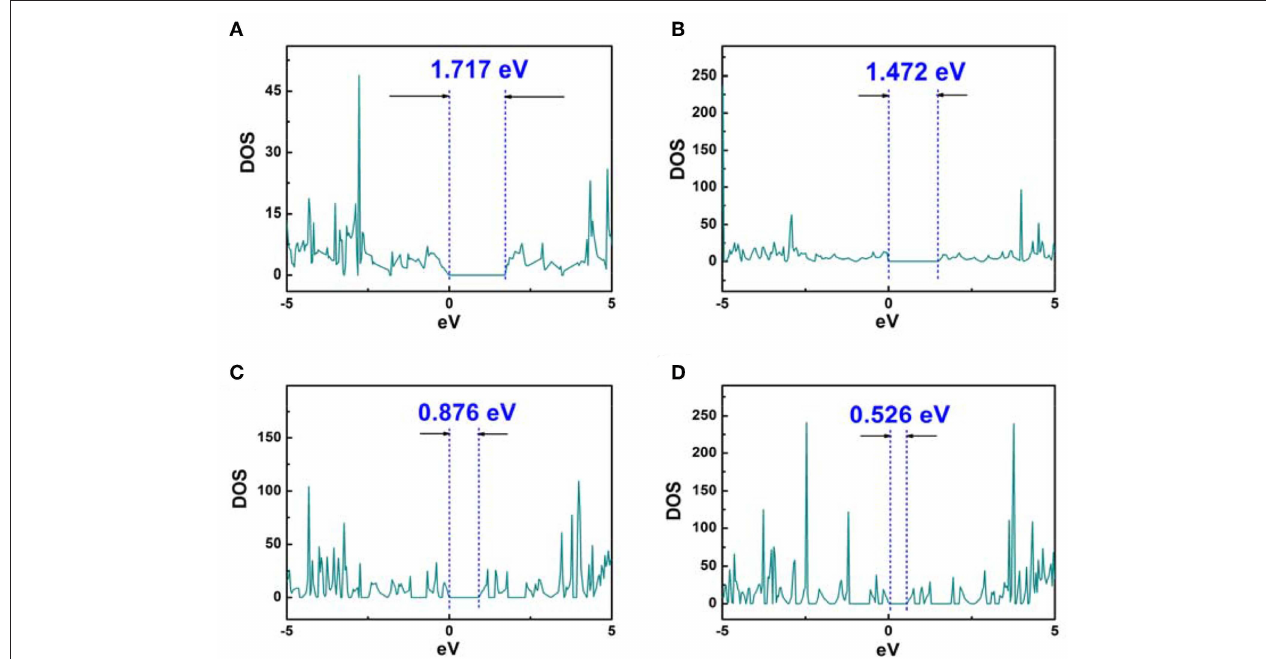
FIGURE 4 | Band Structure Figures of two-dimensional closed conjugated COPs ( A , COP-B3; B , COP-B4; C , COP-B5; D , COP-B6).